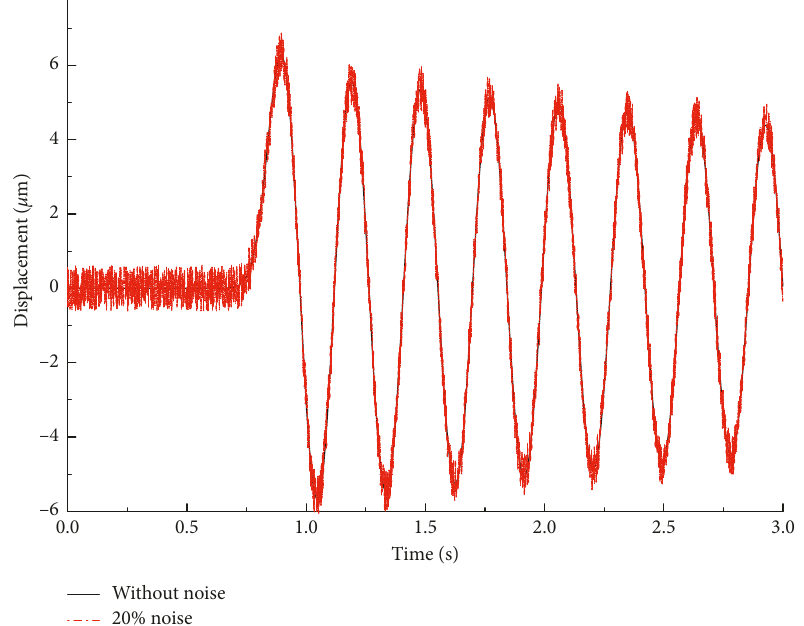
Figure 3: Displacement response of m 2 for the system excited by the impact load before and after adding 20% noise.